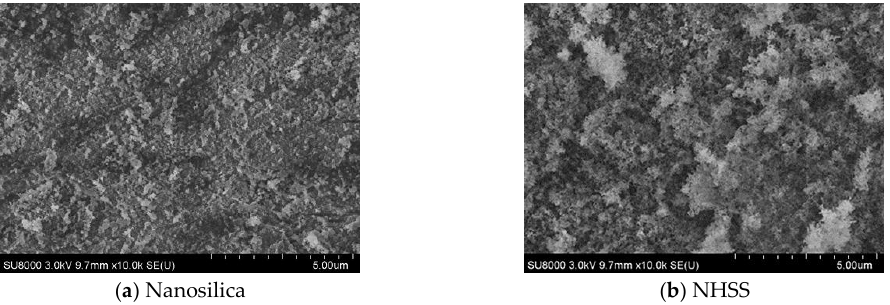
Figure 2. SEM images of nanosilica and nano hydrophobic silane silica (NHSS) at magnifications of ×10000.